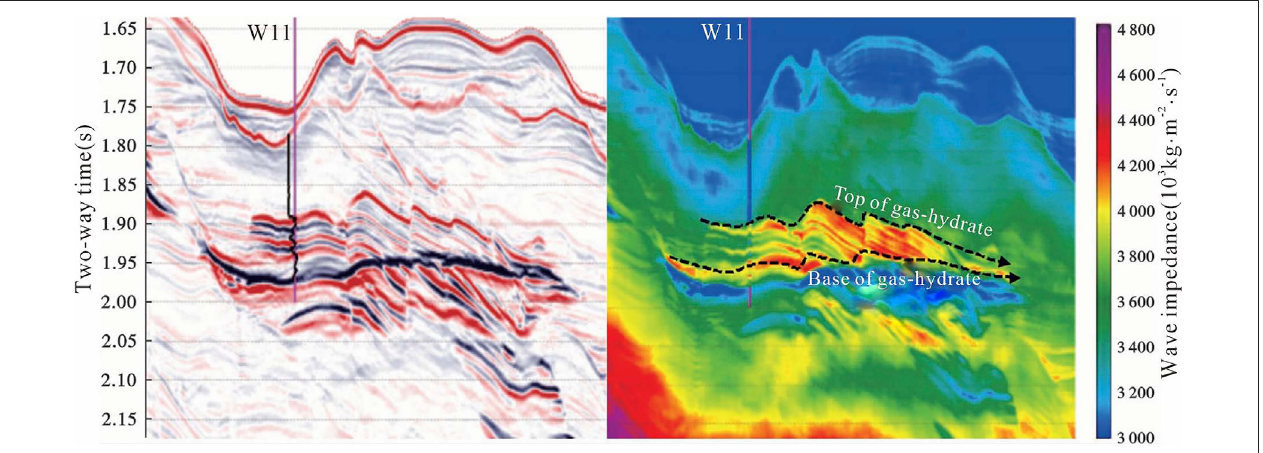
FIGURE 8 | Broadband seismic data of Well W11 (left) and well-free broadband seismic inversion results (Modi fi ed after Li et al., 2019).